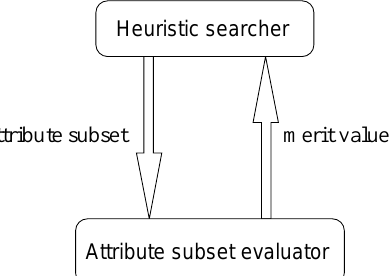
Figure 12. Schema of traditional value-based feature